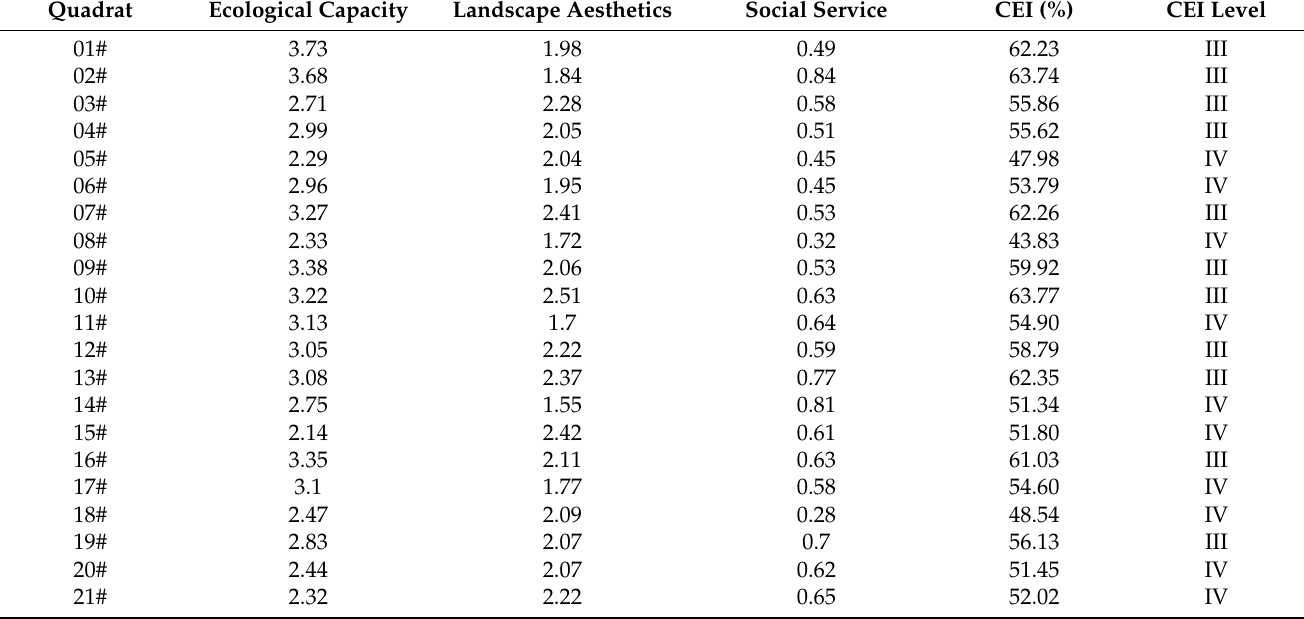
Table 6. Evaluation results of riparian landscape in rural Qingxi area (source: author). Quadrat Ecological